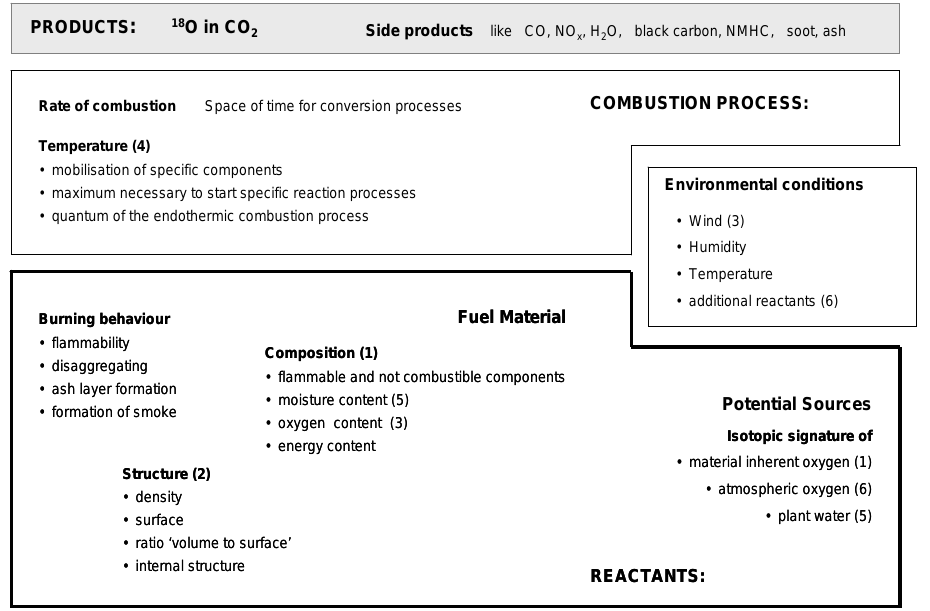
Fig. 2. Major aspects and interactions relevant for combustion processes. The numbers in brackets indicate the several factors focussed on by the specific